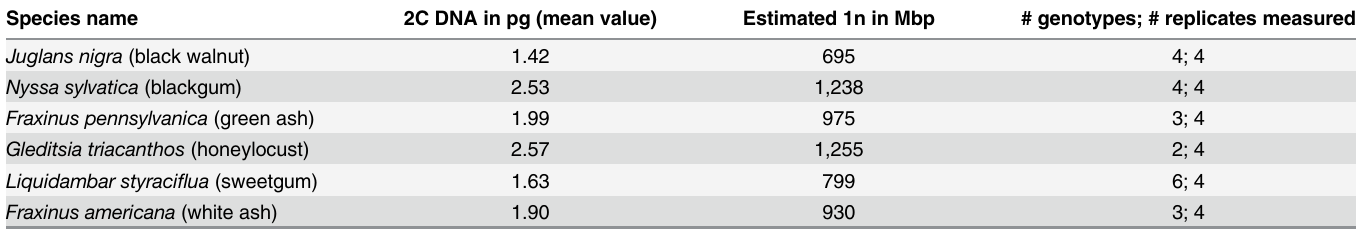
Table 2. Genome size estimates obtained from flow